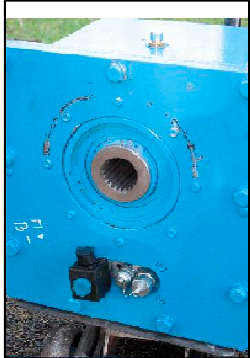
Figure 2. The prototype device.